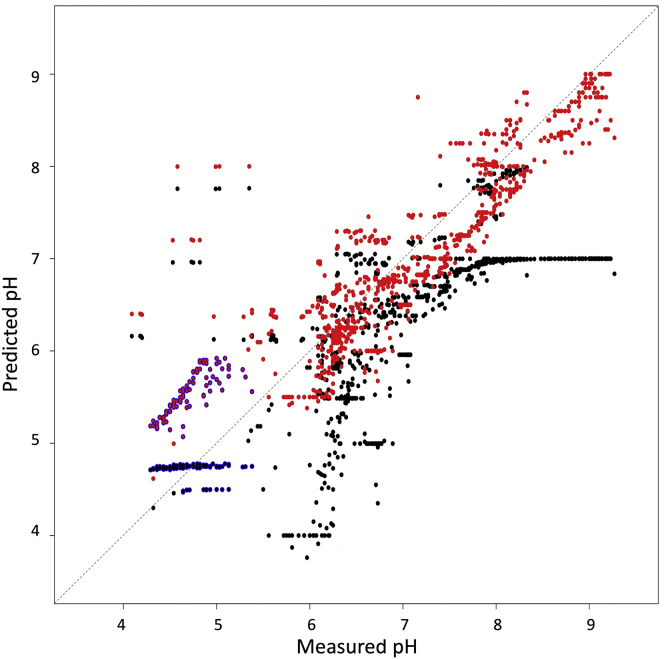
Predicted pH Values for Wells with Two Buffers.Predictions in black are obtained using Equation 4 to calculate the combined buffer pHA. Predictions in red are obtained by simply averaging the two given pH values. Points outlined in blue show the predictions for a series of wells containing sodium acetate-acetic acid together with bis-tris chloride. Although the predicted pH for these wells is better when pH values are combined using Equation 4, all also contain PEG and the measured pH might have been affected by PEG degradation. The points above these with even greater prediction errors not only contain an unusual combination of many organics but also contain at least one PEG.